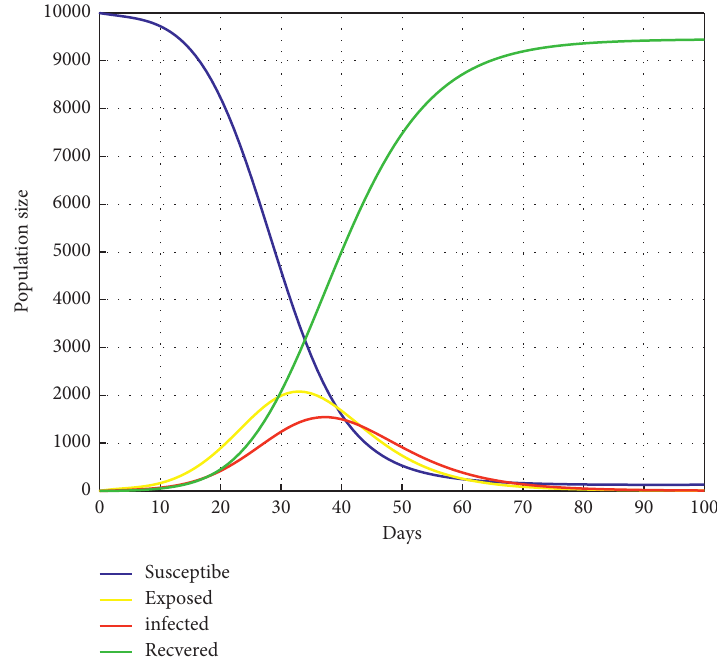
Figure 2: Evolution of the epidemic spreading considering the transmission vector-to-human transmission route only, i.e., infection incidence rate from host to host β hh � 0 and vertical transmission rate π � 0.